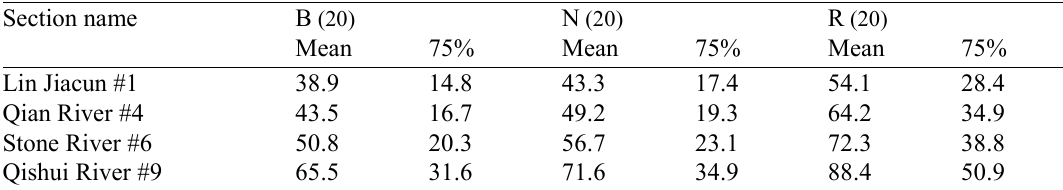
Table 5 Characteristic flows at control sections (m 3 /s).